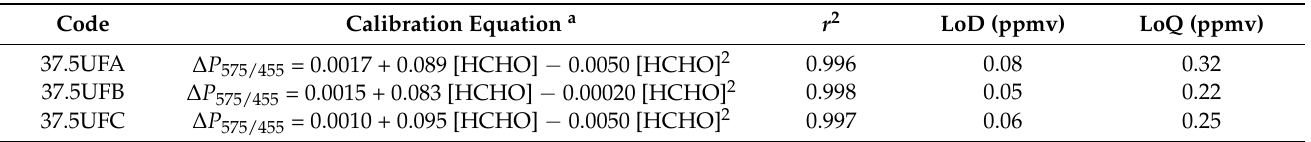
Figure 7. Dose-response curves obtained for three sensitive optical fibers. Each point represents the average of 3 individual measurements ( n ) obtained for each airborne formaldehyde concentration in the 0.6 − 5.5 ppmv range at 50% RH. The error bars depict the confidence interval for a 95% confidence level (± t s n-1 n ⁻ 1/2 ). Table 2. Formaldehyde calibration equations, LoD and LoQ obtained from the corresponding dose- response curve for OFS coded 37.5UFA‒37.5UFC .